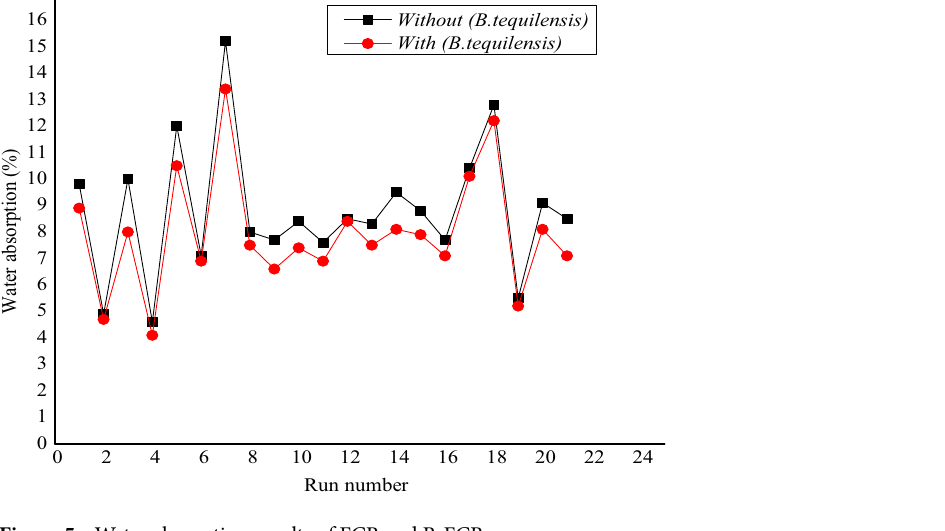
Figure 5. Water absorption results of FCB and